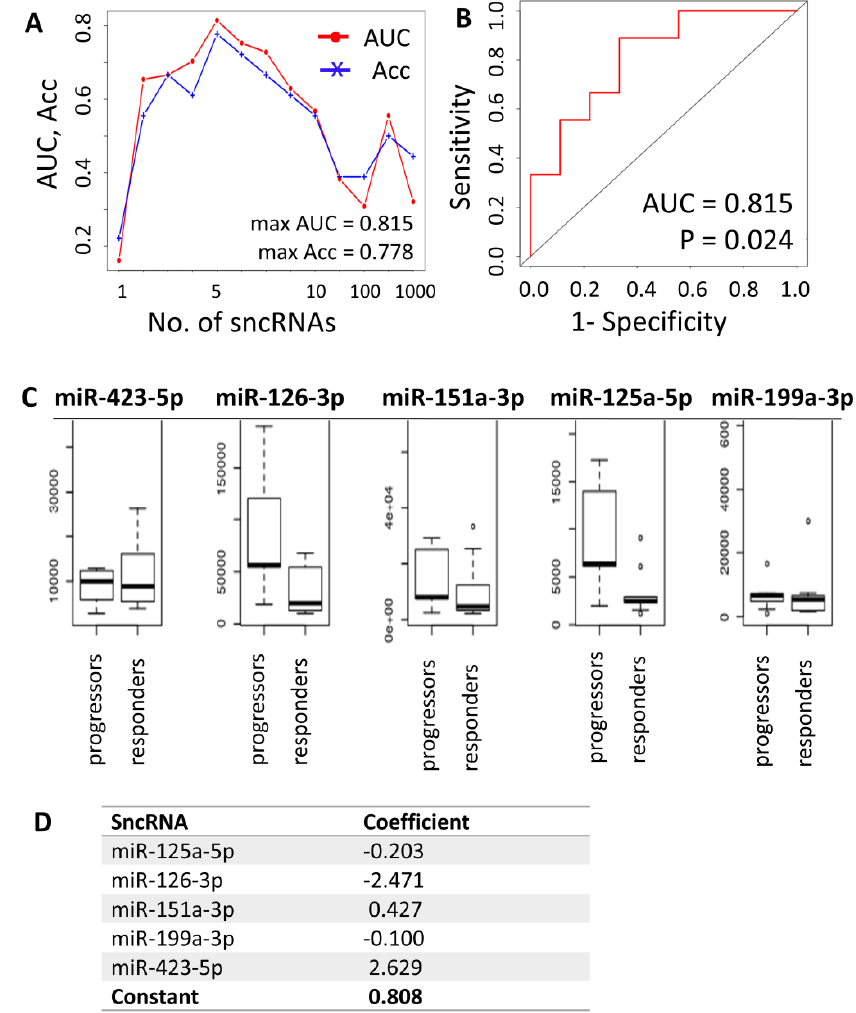
Figure 5. Combined prediction model for response to agent azacytidine (AZA) treatment in MDS/AML-MRC patients. ( A ) Results of the support vector model support vector machine-recursive feature elimination (SVM-RFE) regression model determining the optimal number of sncRNAs whose combined expression could be predictive of the likelihood of response. ( B ) ROC curve for the five sncRNA predictors. ( C ) Plasma levels of the best / most common predictors (miR-423-5p, miR-126-3p, miR-151a-3p, miR-125a-5p, and miR-199a-3p). ( D ) Output of the sag solver analysis for calculation of predictive formula for AZA treatment response. Predictive formula: score = 2.629 × ln(level of miR-423-5p) − 2.471 × ln(level of miR-126-3p) + 0.427 × ln(level of miR-151a-3p) − 0.203 × ln(level of miR-125a-5p) − 0.1 × ln(level of miR-199a-3p) + 0.808. A score > 0 predicts future response to AZA, whereas a score ≤ 0 predicts disease progression despite AZA treatment. AUC—area under the ROC curve, Acc—accuracy.